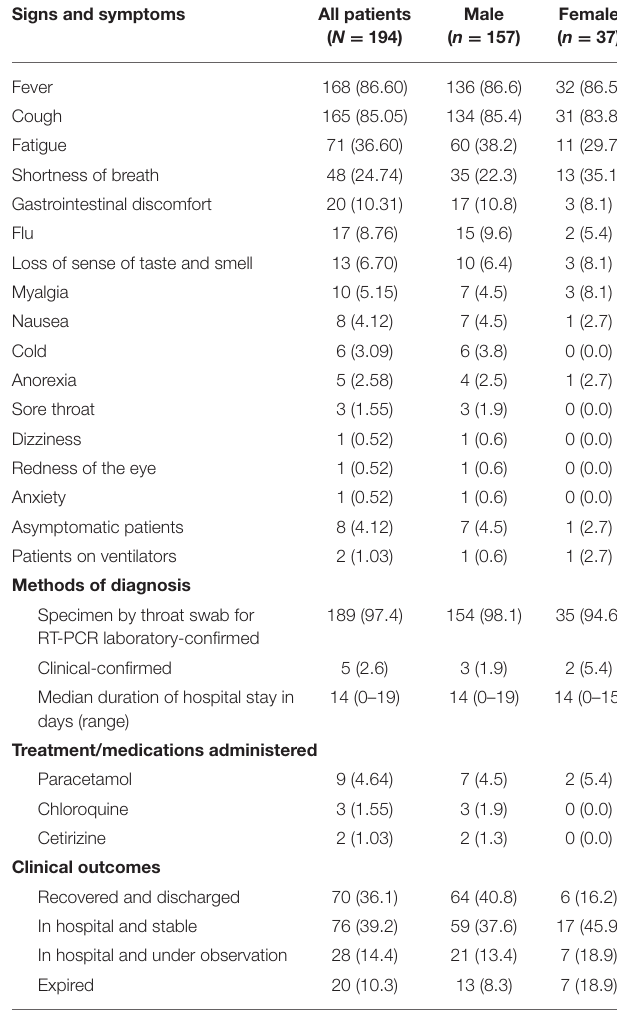
TABLE 2 | Clinical features, signs, symptoms, methods of diagnosis, medications, and outcomes. Signs and